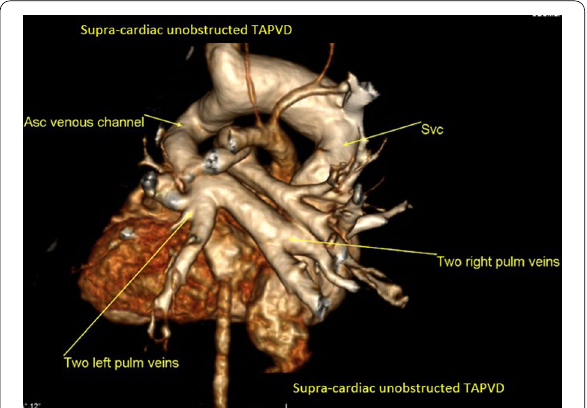
Fig. 4 3D volume rendering image showing total anomalous pulmonary venous drainage unobstructed supra-cardiac type of the four pulmonary veins